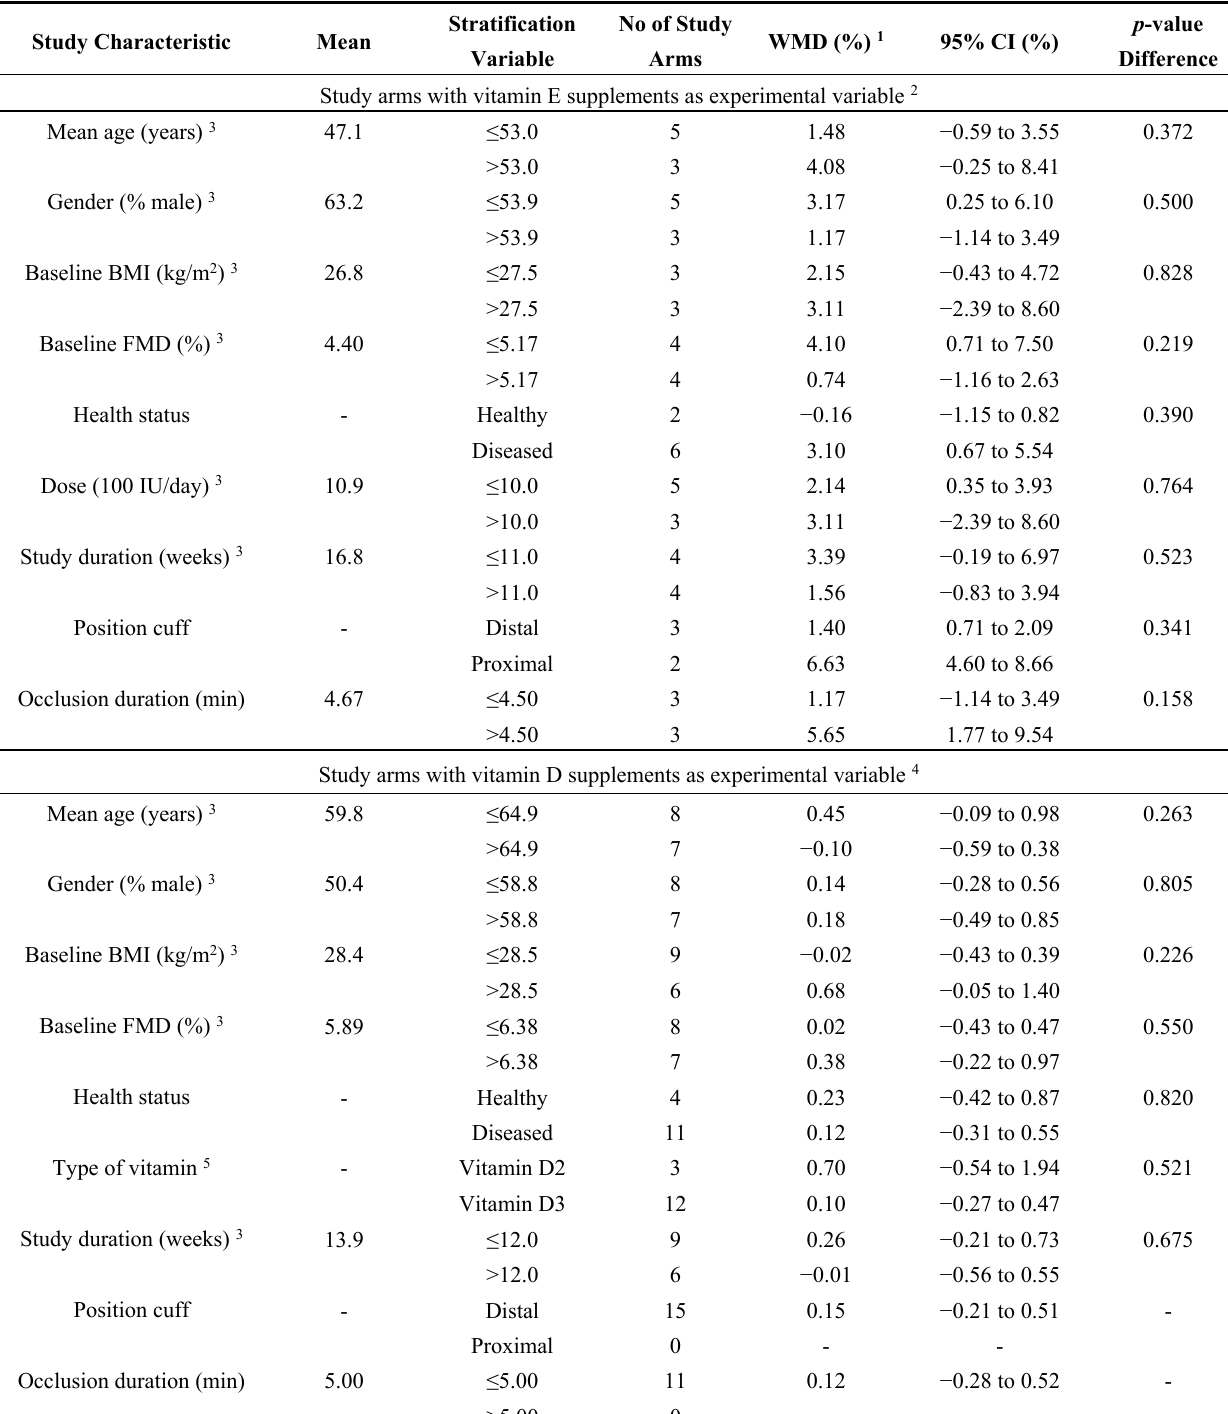
Table 2. Subgroup analyses for the effect of fat-soluble vitamin E and vitamin D supplementation on fasting flow-mediated vasodilation (FMD) in